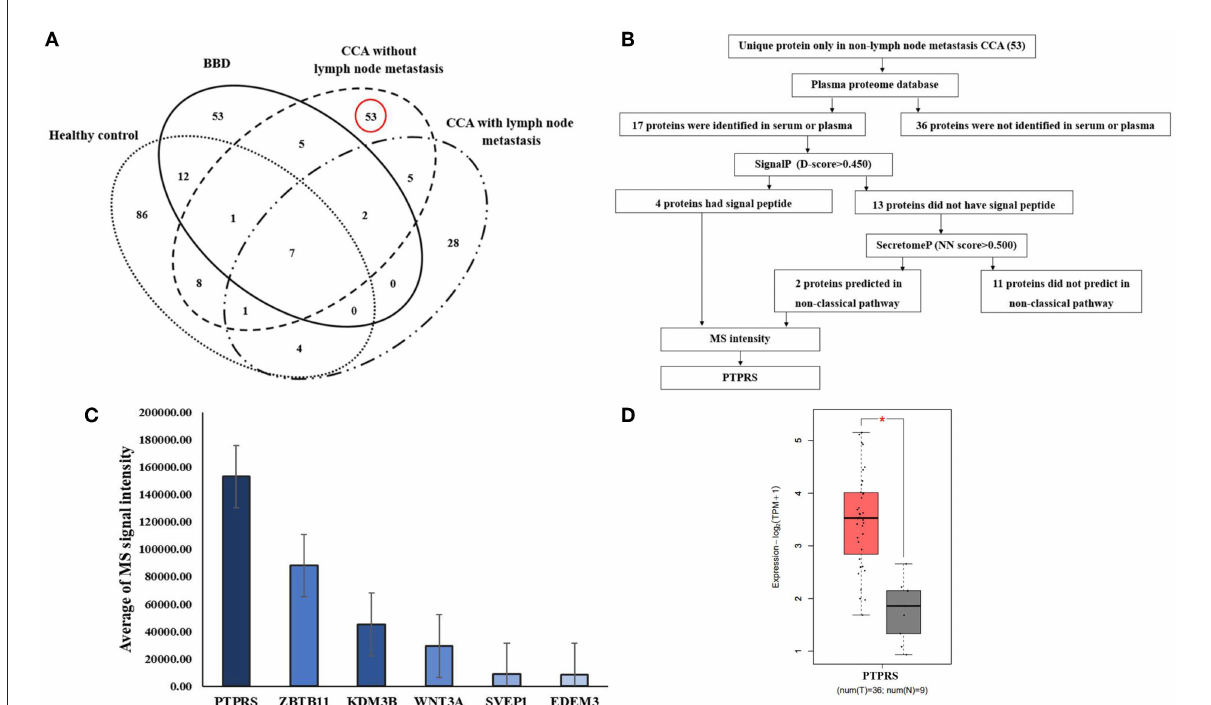
FIGURE1 Identification of candidate proteins. (A) The Venn diagram presents the number of proteins in each group and the degree of overlapping of proteins. The dotted oval: total proteins identified in HC, the solid oval: total proteins identified in BBD group, the dashed oval: total proteins identified in CCA without LN metastasis, and the dash-dotted oval: total proteins identified in CCA with LN metastasis. (B) Flowchart of selection of secretory proteins in CCA without LN metastasis. (C) Average MS signal intensity level of six candidate proteins. (D) mRNA expression of PTPRS in CCA (as CHOL) tissue was analyzed by using GEPIA2. T, tumor (red box), N, normal (gray box). * Statistical significance ( P <